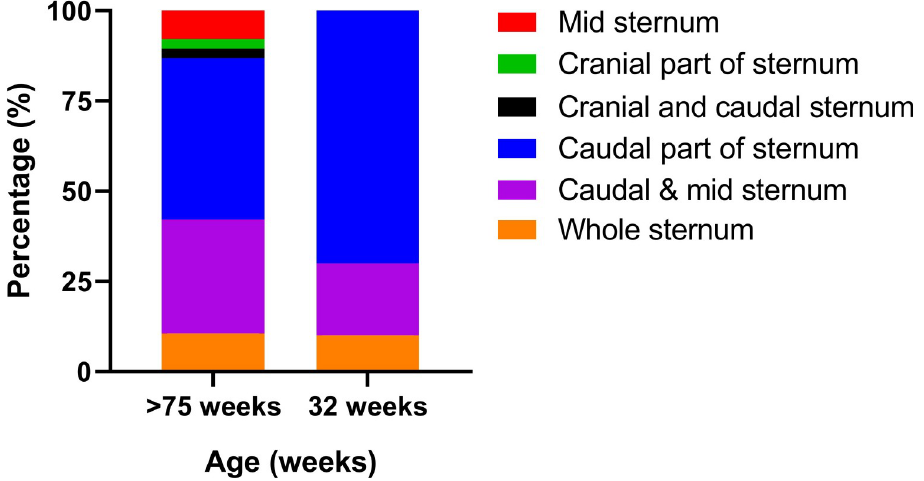
Fig 4. Distribution of the localization of fractures identified by CT scan in old (n = 38) and young birds (n = 10). Data is presented as percentage within age group.